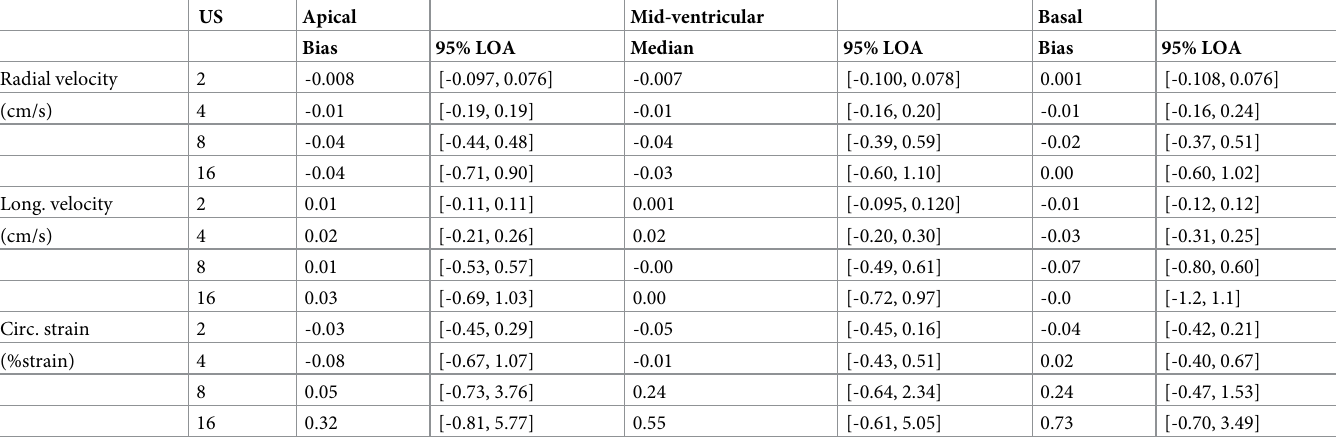
Circumferential strain was calculated from temporal integration of the myocardial velocity field measured by TPM [5,20]. US = undersampling factor. LOA = limits of